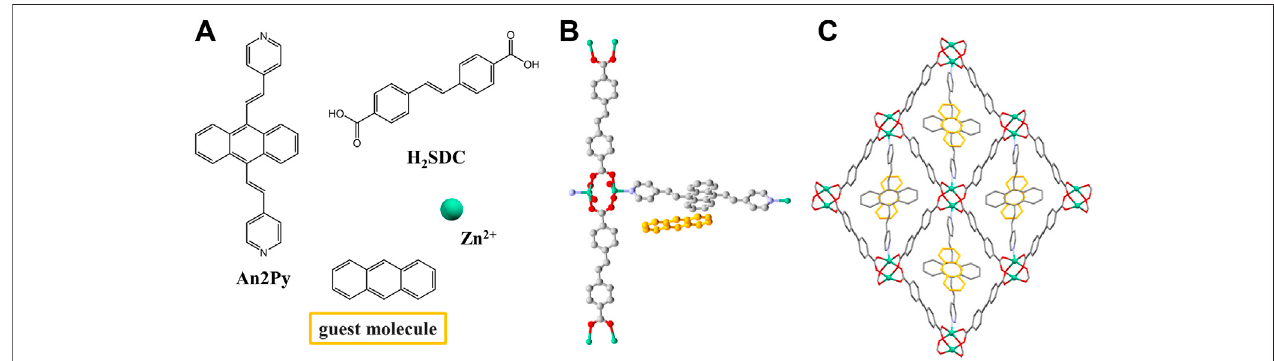
FIGURE 1 | (A) Chemical structure of the ligand trans, trans -9,10-bis(4-pyridylethenyl)anthracene (An2Py), trans, trans -4,4 ′ stilbenedicarboxylic acid and anthracene. (B) Coordination environmentofAn2Py (C) aviewofMOFcontainingtheligand withencapsulatedanthracene(orange)guestalongaxis a.Readapted from (Quah et al.,